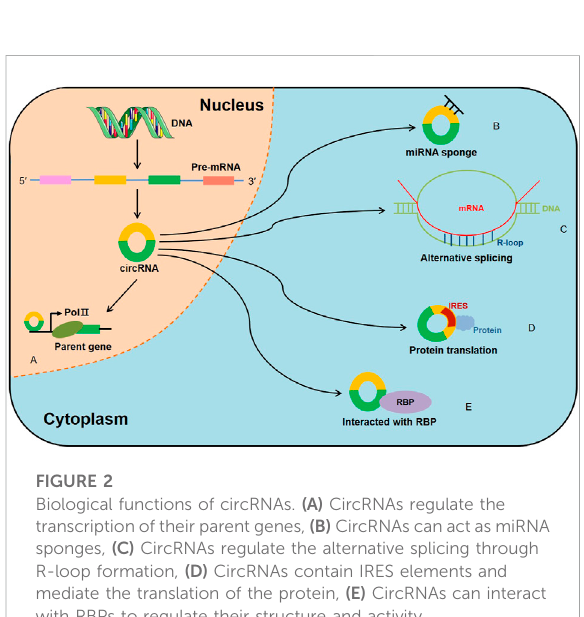
FIGURE 2 Biological functions of circRNAs. (A) CircRNAs regulate the transcription of their parent genes, (B) CircRNAs can act as miRNA sponges, (C) CircRNAs regulate the alternative splicing through R-loop formation, (D) CircRNAs contain IRES elements and mediate the translation of the protein, (E) CircRNAs can interact with RBPs to regulate their structure and